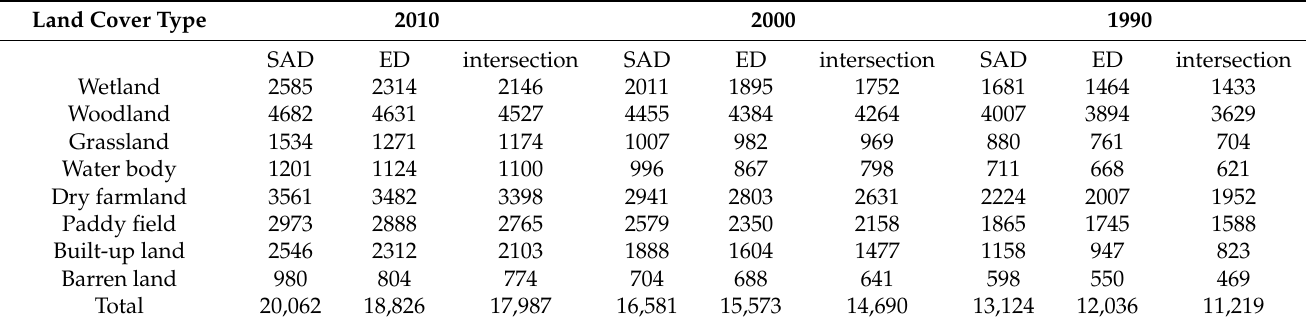
Table 2. Unchanged training sample pixels detected by SAD, ED and an intersection criterion (ED ≤ 0.2 and SAD ≥ 0.9). Land Cover Type